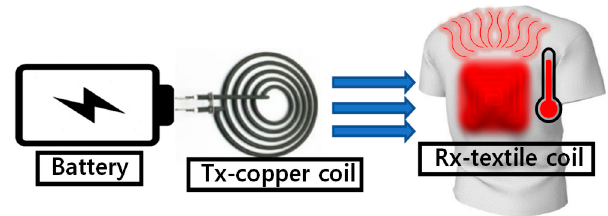
Figure 1. Simplified conceptual representation of proposed wearable heater using inductive power transmission with textile coil.